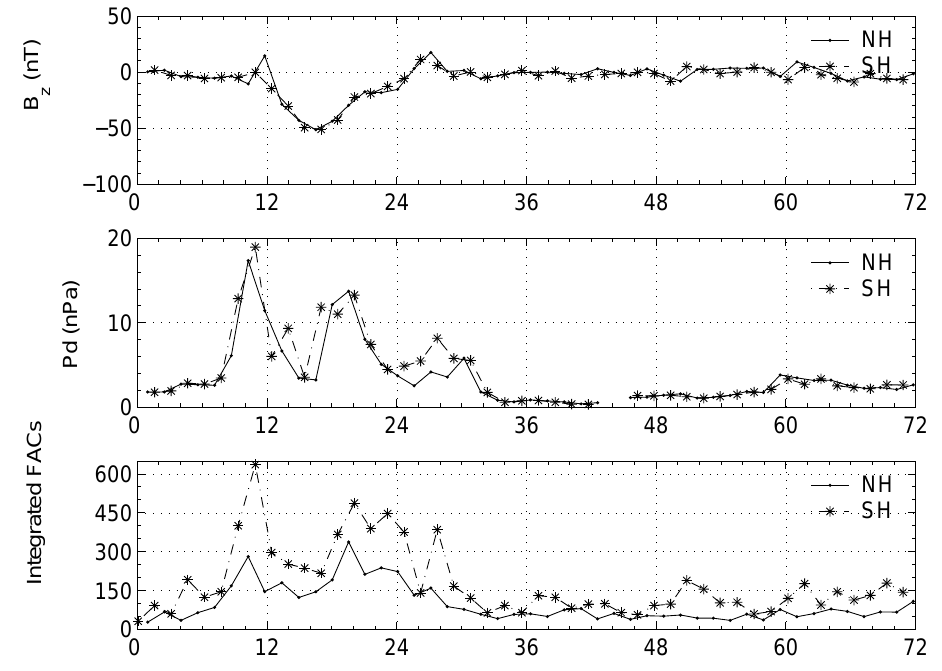
Fig. 11. Storm-time B z , P d and integrated FACs’ strength along the orbit segments ( 6 | j z | ) observed by CHAMP in the daytime sector on 20–22 November 2003 in the Northern and Southern